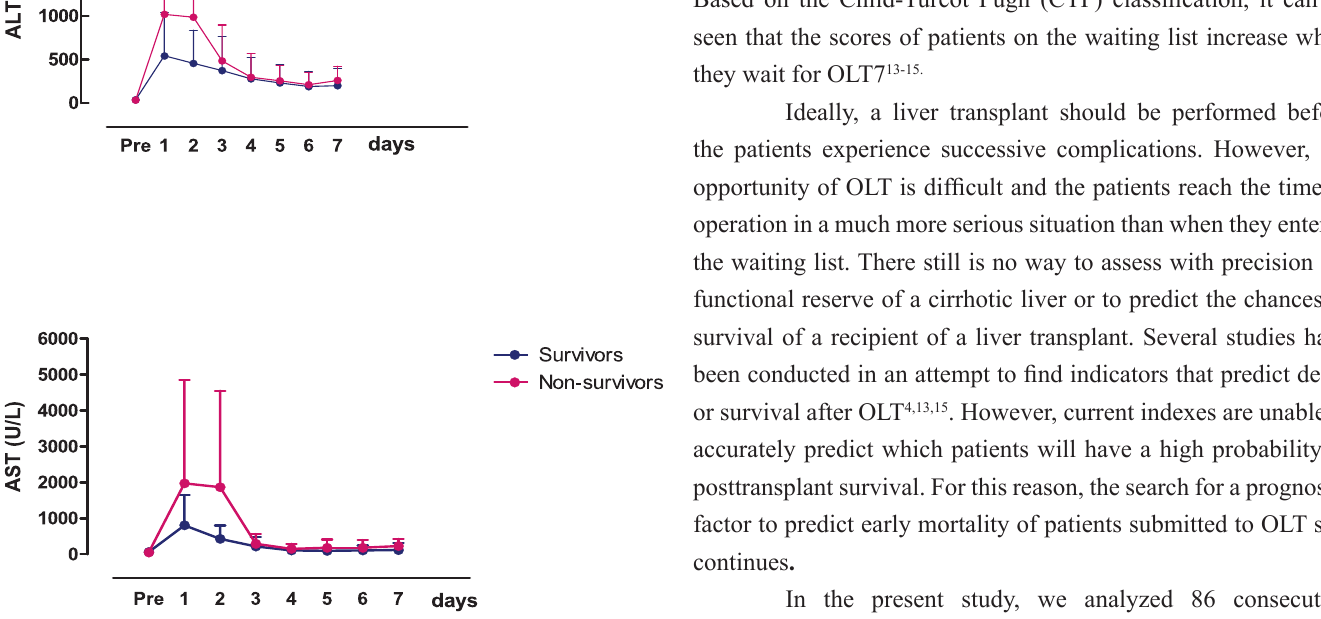
FIGURE 5 - Aminotransferase values, ALT (panel A) and AST (panel B), determined preoperatively and for seven days postoperatively were similar for the survivor and non-survivor